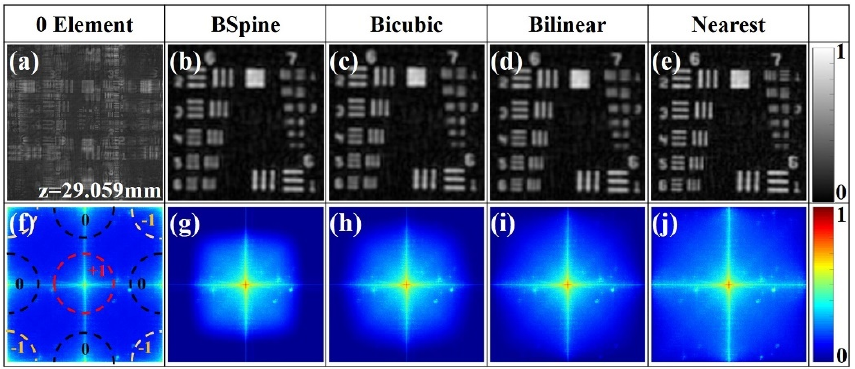
Figure 5. Magnified amplitude images and spectral images of the normalized reconstructed images obtained using the HIM when the interpolation algorithms were ( a , f ) 0 element, ( b , g ) B-spline, ( c , h ) bicubic, ( d , i ) bilinear, and ( e , j ) nearest-neighbor.